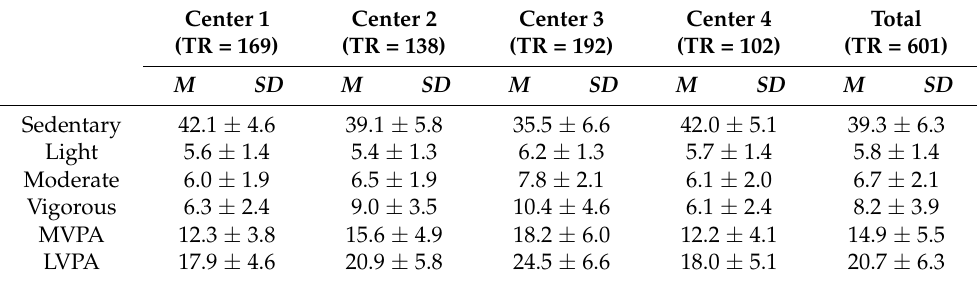
Table 6. PA performed in the different centers during recesses